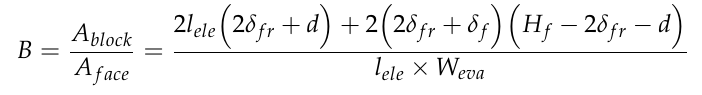
Figure 9. Single-row pressure drop during frosting 400 min duration. As frosting progresses, the frost layer gradually blocks the flow channel between adjacent fins, and leads to the increase in local pressure drop. Hence, the single-row pressure drop depends mainly on the blockage ratio defined by Equation (8).